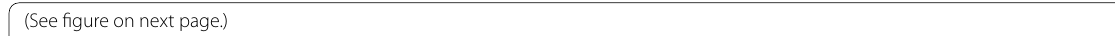
(See figure on next page.) Fig. 3 Examples of extreme discrepant results between the two software ( a , b ) and between the expert reading and either of the two software ( c ). a A 80-year-old man with de novo Parkinson’s disease presenting with bradykinesia, right hand resting tremor and upper arm rigidity, mainly on the right side. The diagnosis is confirmed at 1-y follow-up visit with moderate response to L-DOPA therapy. On DAT SPECT, the experts report reduced tracer uptake in both putamina, mainly on the left side, consistent with clinical presentation. BasGanV2 (upper right) identifies normal caudate uptake but significantly reduced putamen uptake bilaterally. This finding is missed by Datquant ® that even shows SBR values at the upper limit of normalcy (upper left). The two images in the lower part of a are examples of ROI drawing on the basal ganglia and background, the latter partially falling outside the brain in the right image. Of note, Datquant ® correctly highlights a reduced ratio between putamen and caudate uptake (z-score 3.47 on the left side) thus confirming that the bias is introduced by the background ROI. On left, for Datquant ® , the position of patient − SBR ( y -axis) is shown in red in the graph, while gray points report values in normal subjects and the gray lines represent the mean with upper and lower limits of normal distribution, respectively, according to age ( x -axis). This is shown for each of the four nuclei On right, for BasGanV2, the patient SBRs of either the two caudate nuclei or the two putamen are reported together, the right side in green and the left side in red; the black line represents the mean of normal controls with respect to age ( x -axis), while the red and the green line report the 90% and 97% confidence level of the normal distribution, respectively. The two images on right are examples of ROI drawing on the basal ganglia and background. b A 60-year-old man with essential tremor. The diagnosis is confirmed at 1-y follow-up visit with moderate response to propranolol therapy. On DAT SPECT, the experts report a normal scan. This is confirmed by Datquant ® analysis (mid-left), whereas BasGanV2 (mid-right) identifies borderline SBR values for caudate and significantly reduced SBR for putamen bilaterally. Other details as in a . c A 80-year-old man with de novo Parkinson’s disease presenting with bradykinesia, both resting and intention tremor at upper arms, with prevalence on the right side, constipation and REM sleep behavior disorder. The diagnosis is confirmed at 1-y follow-up visit with good response to L-DOPA therapy. On DAT SPECT, the experts report reduced tracer uptake in both putamina, mainly on the left side, consistent with clinical diagnosis. On the contrary, both Datquant ® (bottom left) and BasGanV2 (bottom right) identify normal caudate and putamen SBRs. Other details as in